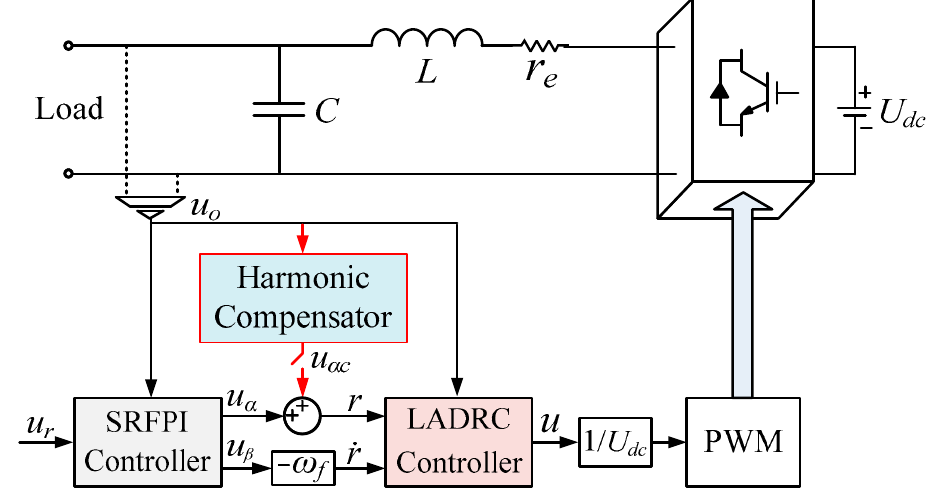
Figure 10. Block diagram of HC-SRFPI-LADRC for inverter system.